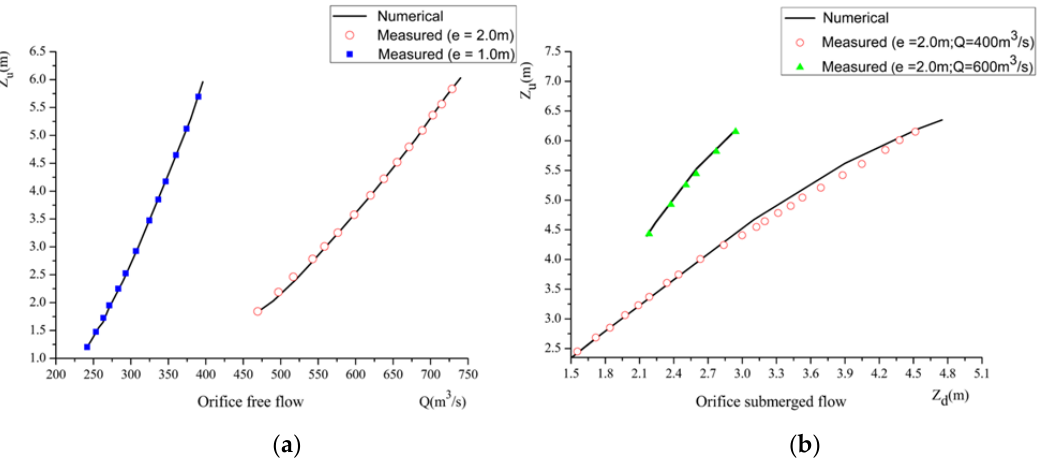
Figure 7. Comparison between numerical results and experimental measurements at t = 900 s: ( a ) Orifice free flow; ( b ) Orifice submerged flow.